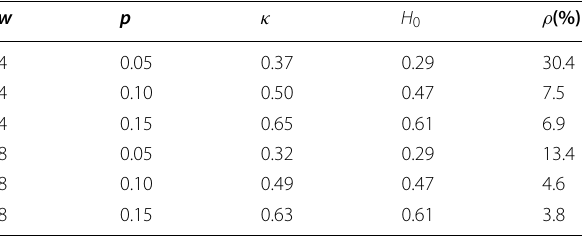
Table 2 Observed redundancy ρ of Tunstall code Table 3 4-bit Tunstall code for p =